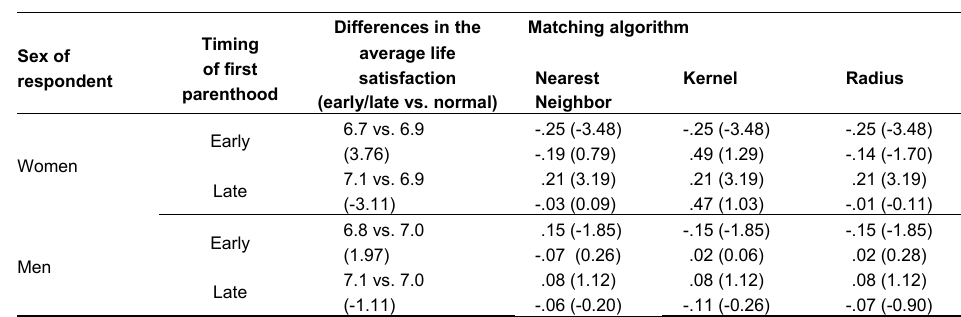
Table 3 : Propensity score matching estimates of the effects of timing of first parenthood, different algorithms, ATT before and after matching (t-statistic in